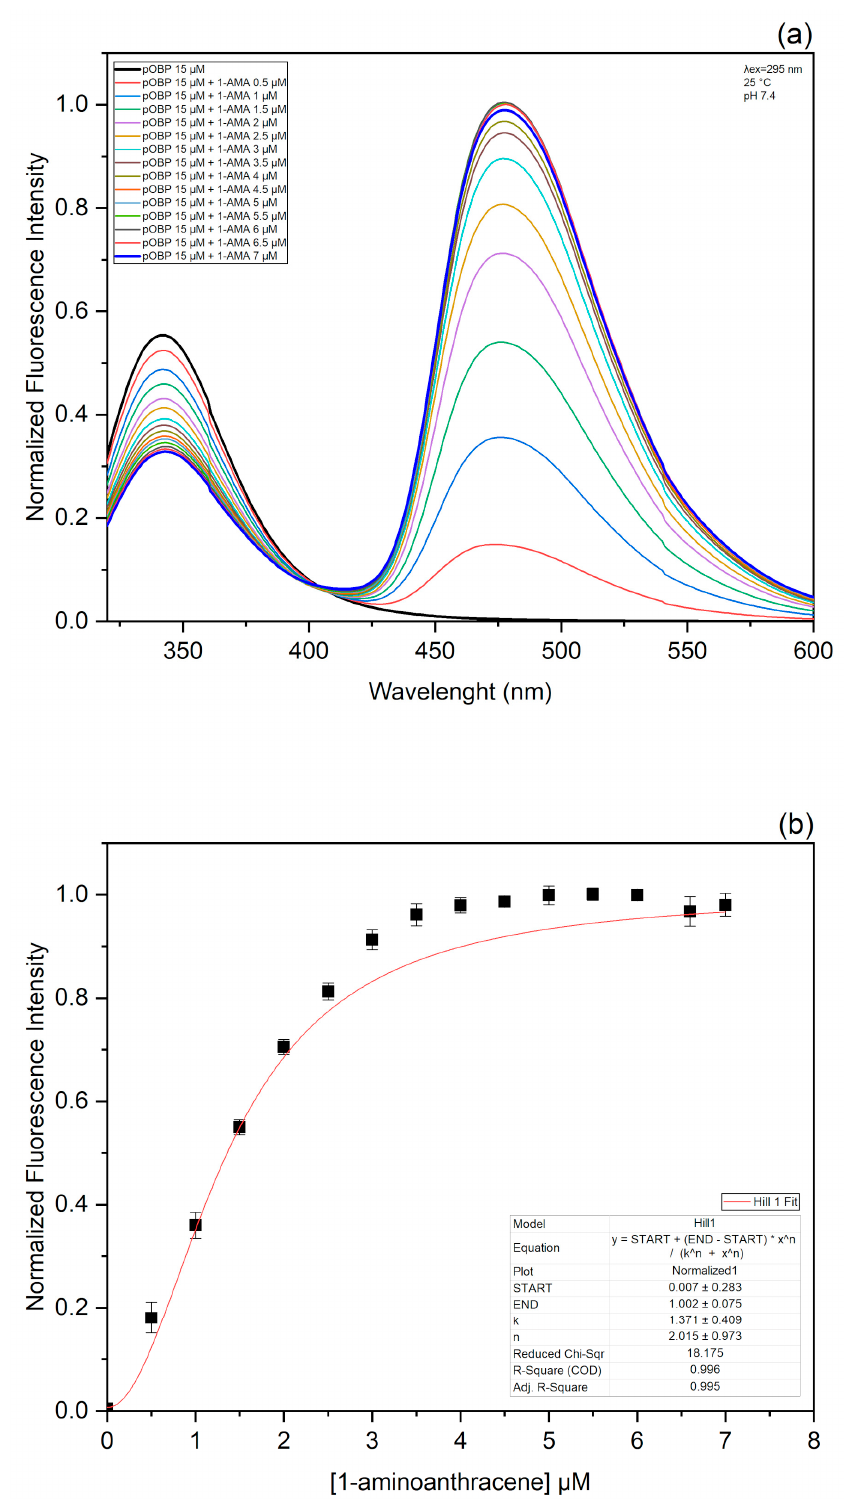
Figure 3. 1-AMA titration curve spectra and titration curves fitting: ( a ) The emission spectra of pOBP upon excitation at 295 nm were acquired in the absence and in the presence of different amounts of 1-AMA; ( b ) fluorescence emission intensity at 481 nm was plotted as a function of 1-AMA concentrations.